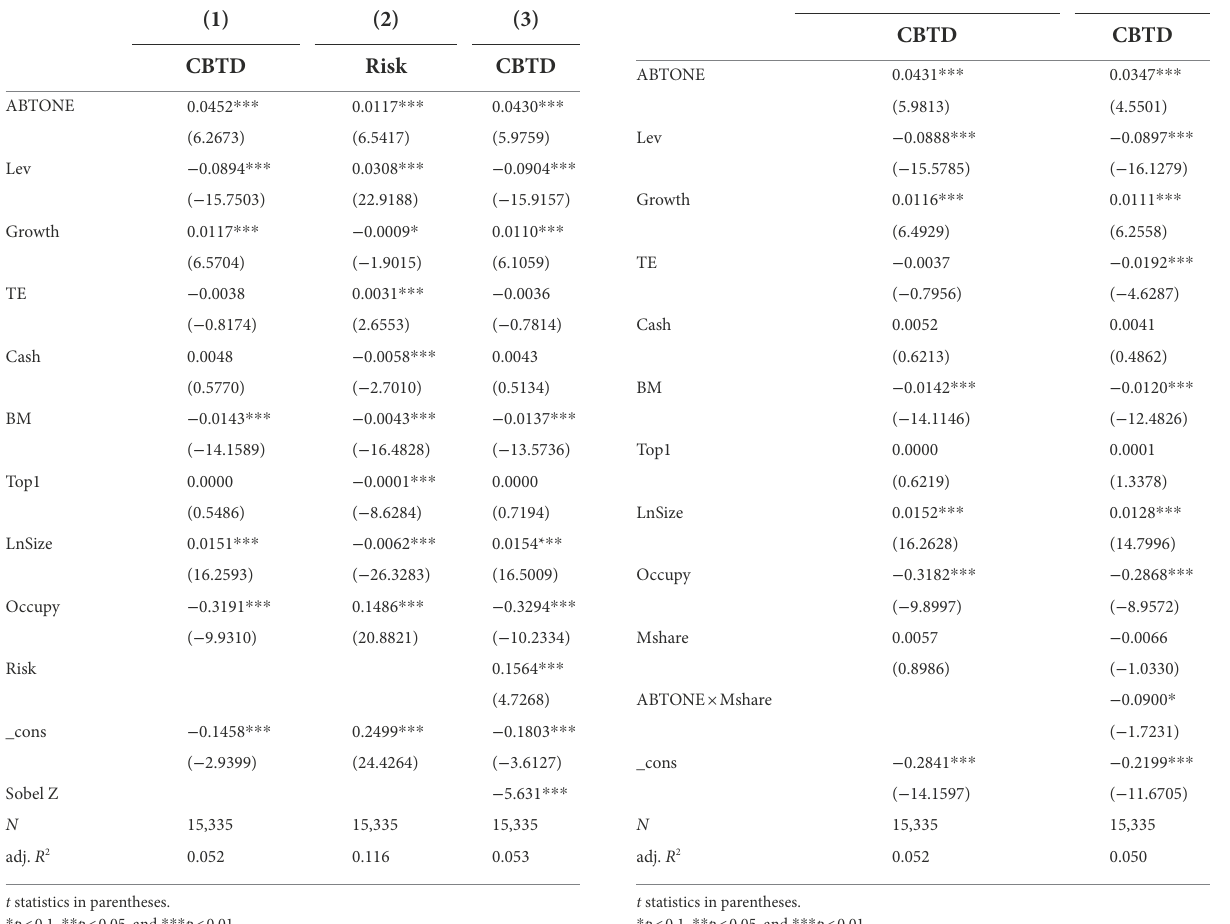
TABLE 3 Mediating effect of corporate risk-taking level.